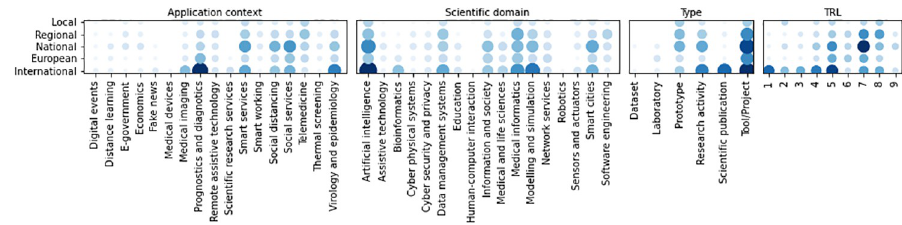
Fig 14. Co-occurrence of geographic scope with the other categorisations.